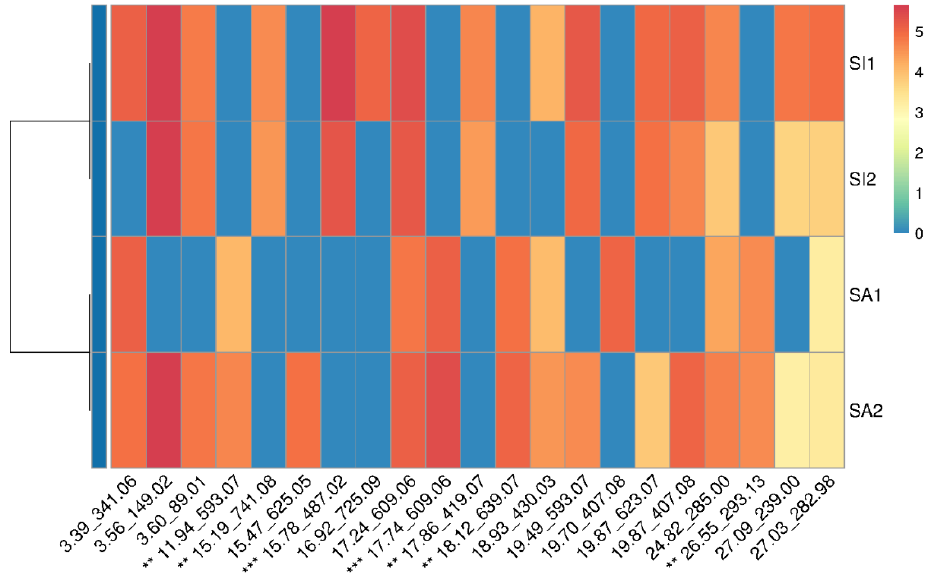
Figure 6. A 2D heat map representing semi-quantitative distribution and metabolite profiling of samples 100% MeOH extract of S. alexandrina (SA1), 100% MeOH extract of S. italica (SI1), 70% MeOH extract of S. alexandrina (SA2), and 70% MeOH extract of S. italica (SI2). Sample identity is displayed on the y-axis (right-hand-side of the heatmap). The importance score of each feature is indicated by asterisks. Bayesian clustering was applied. Features (RT and m / z values) are represented on the x-axis. The color intensity (blue to dark red) refers to compound abundance in each sample. ** p < 0.01, *** p < 0.001. (For interpretation of the references to color in this figure legend, the reader is referred to the web version of this article.)